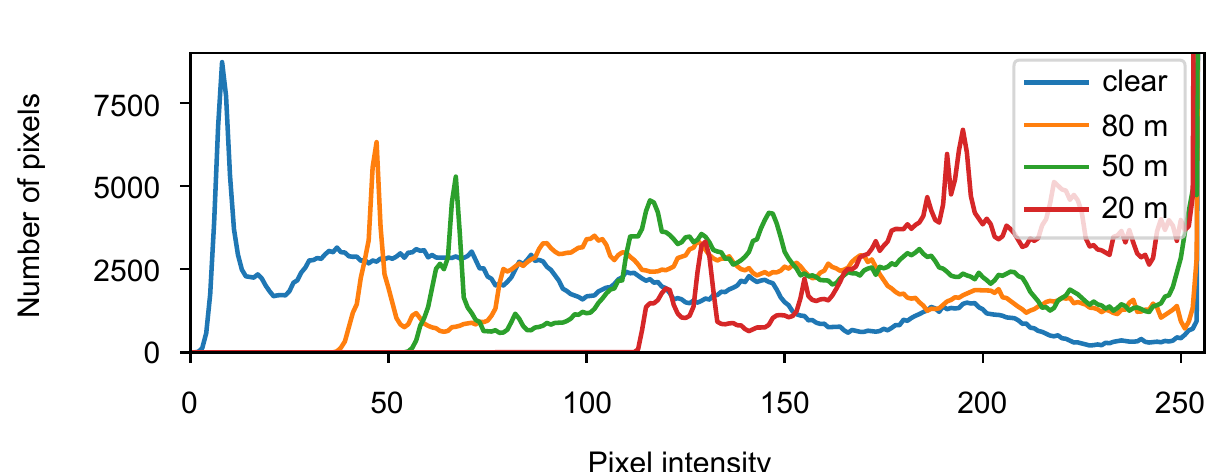
( b ) The image histogram shows the pixel intensity distribution of four images in ( a ) which are converted to gray scale images here for simplicity. Figure 2. The distortion of the image and point cloud according to different levels of visibility in a foggy scene. As visibility decreases, the contrast of the image and the range of the point cloud also decrease significantly, as shown in ( a , b